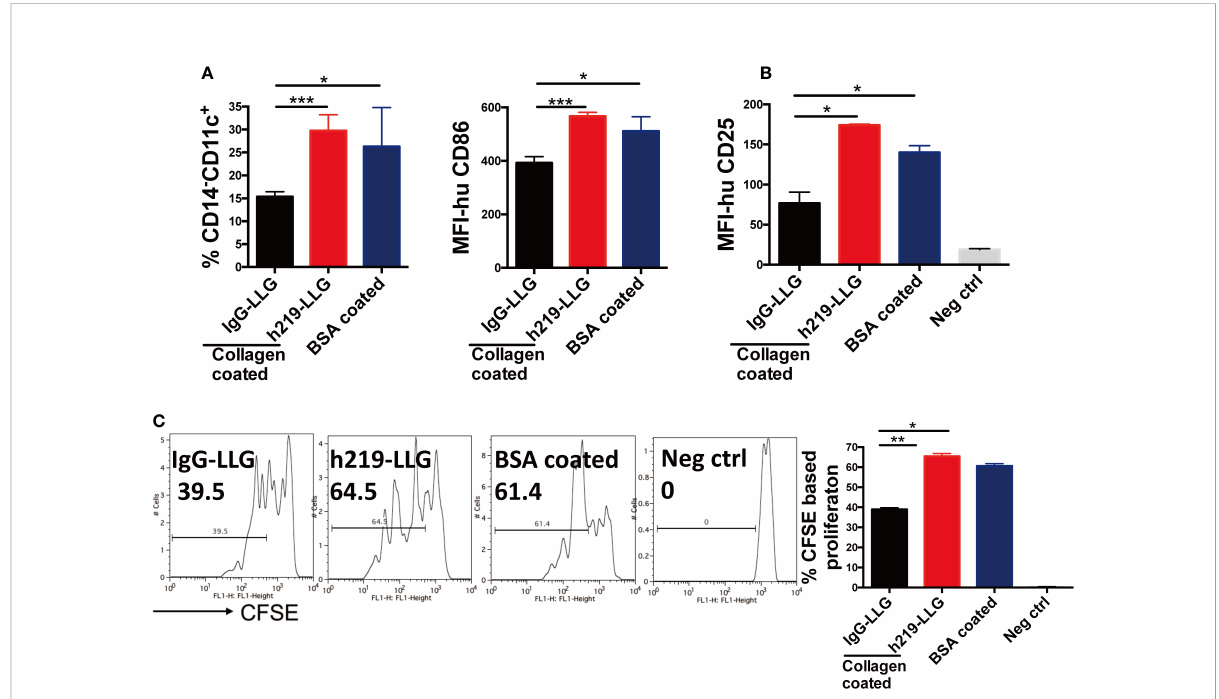
FIGURE 4 Inhibition of LAIR1 enhances dendritic cell differentiation and dendritic cell- induced T cell proliferation in MLR assay. (A) CD14 + monocytes isolated from fresh human PBMCs were cultured with GM-CSF and IL-4 for 2 days. The expression of CD11c on CD14 negative population and CD86 were detected. (B, C) Matured DCs were mixed with allogenic T cells in the MLR assay. Surface CD25 (B) and CFSE based cell proliferation were determined by fl ow cytometry at 72 hours (C). As Statistical Analysis in Methods stated: * indicates p < 0.05; ** indicates p < 0.01, *** indicates p <